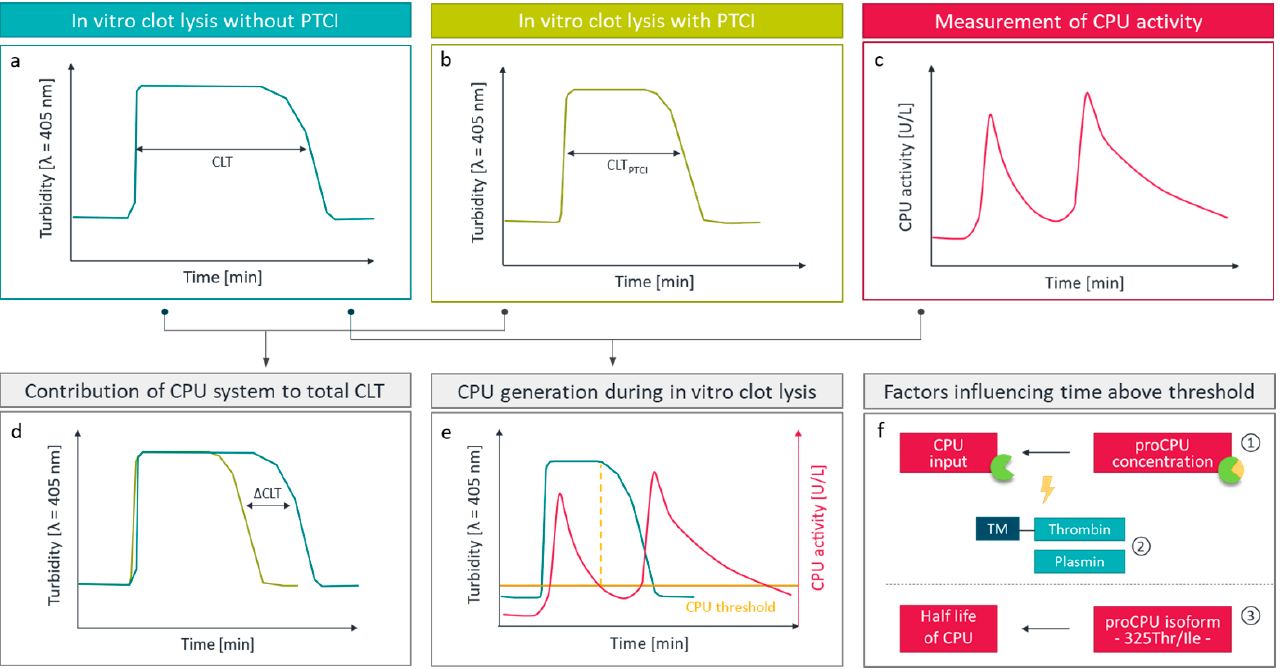
Figure 2. Functional assessment of carboxypeptidase U (CPU). The contribution of CPU to the total clot lysis time ( Δ CLT; d ) can be visualized by means of in vitro clot lysis experiments in the absence ( a ) or presence ( b ) of potato tuber carboxypeptidase inhibitor (PTCI) or a selective CPU inhibitor. During in vitro clot lysis, CPU is generated shortly after initiation of the coagulation—when proCPU is activated by thrombin(-thrombomodulin)—resulting in a first CPU activity peak ( c ) and halting fibrinolysis as long as the CPU level remains above a certain threshold value ( e ). This threshold concentration is dictated by steady-state plasmin concentrations, and thus dependent on tissue-type plasminogen activator (tPA) and plasmin inhibitor concentrations. Once CPU activity falls below this critical threshold value, fibrinolysis accelerates and the generated plasmin gives rise to the formation of a second CPU activity peak ( c , e ). The time that the CPU stays above the threshold ( f ) is defined by ( 1 ) the procarboxypeptidase U (proCPU) concentration, ( 2 ) the extent of proCPU activation — and thus the concentrations of thrombin(-thrombomodulin)—and ( 3 ) the CPU half-life, defined by the Thr/Ile325 polymorphism.